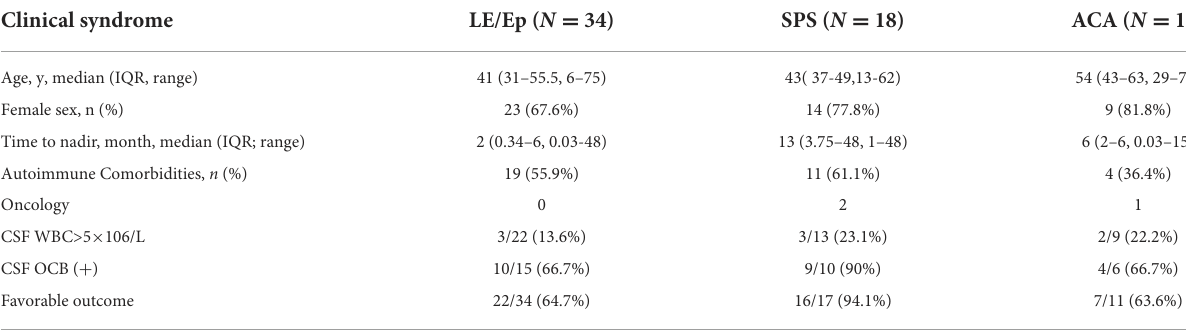
TABLE 2 Different clinical syndromes of GAD65-ab-associated neurological autoimmunity.